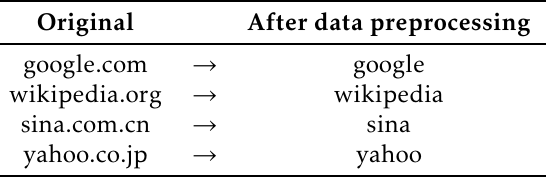
Table 2. Data preprocessing